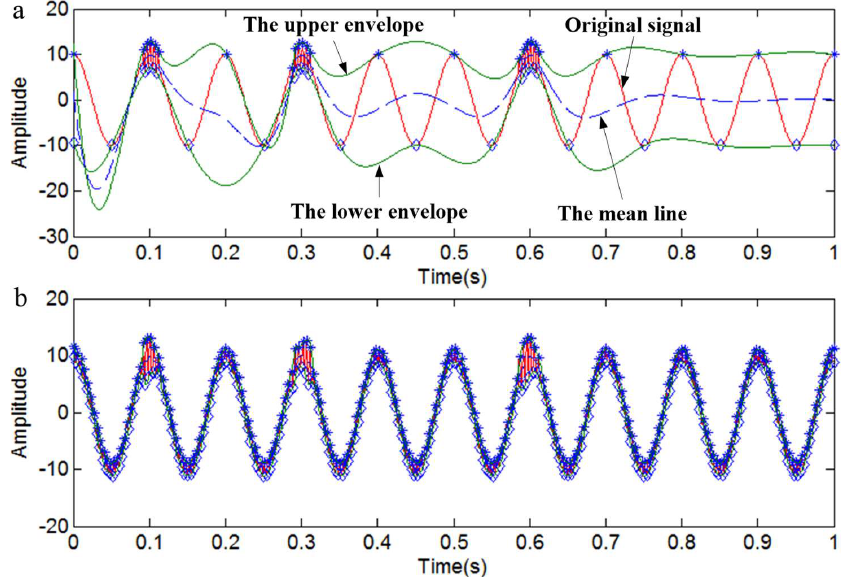
Figure 8. The envelopes. ( a ) The envelopes of a simulated signal; ( b ) The envelopes after adding a high-frequency sinusoidal signal.